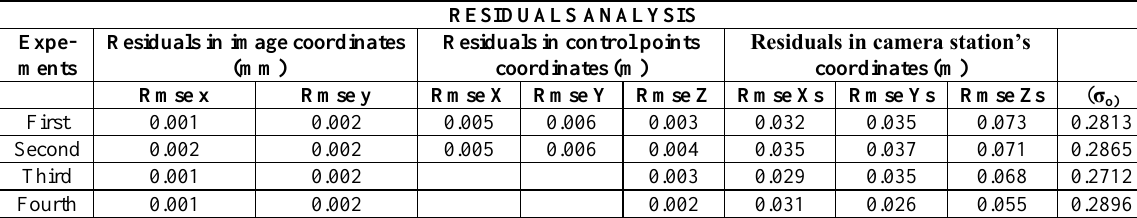
Table 3. Main results of the residuals analysis performed in the experiments of the in situ sef-calibration Mean Absolute Values of the Correlation Coefficients Among Orientation Parameters and IOP